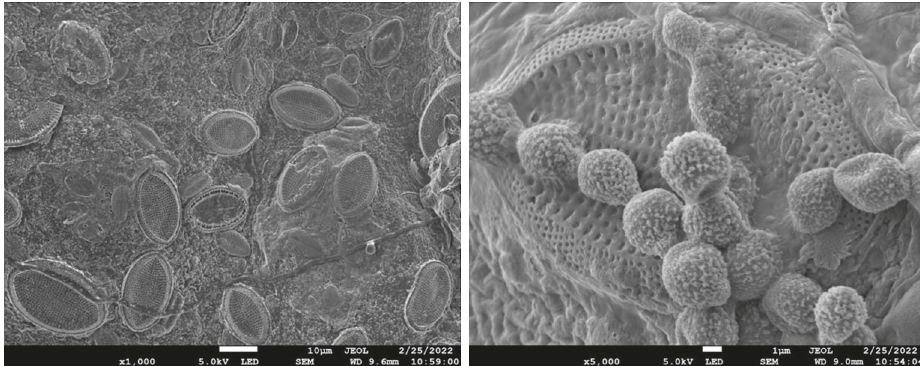
Figure 3: Scanning electron microscopy (SEM) images of Caulerpa lentillifera at 10 μ m and 1 μ